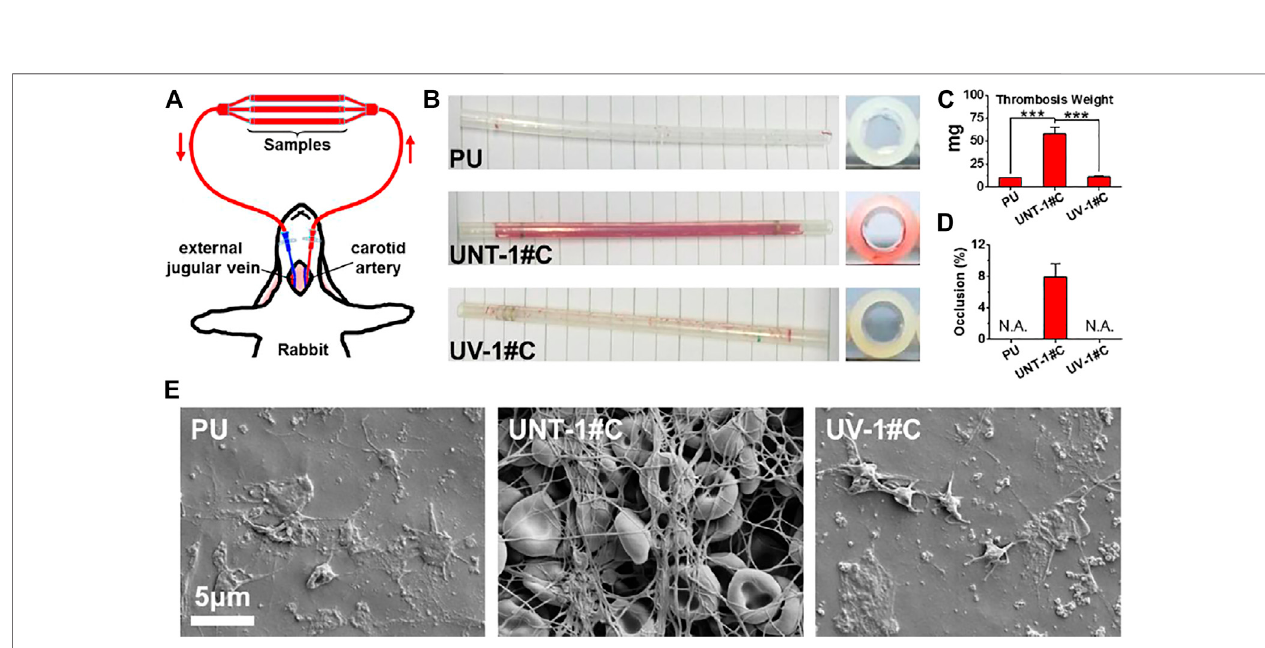
( Figure 4C ) showed that all nanoparticles coatings signi fi cantly